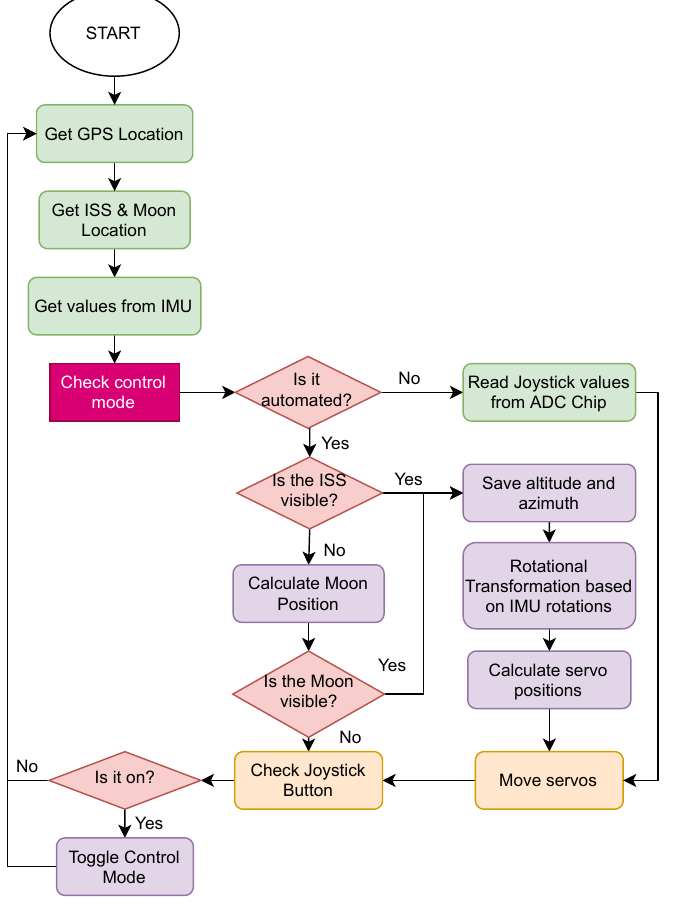
Figure 4. Flow of information, and interactions and communication between various components in the proposed